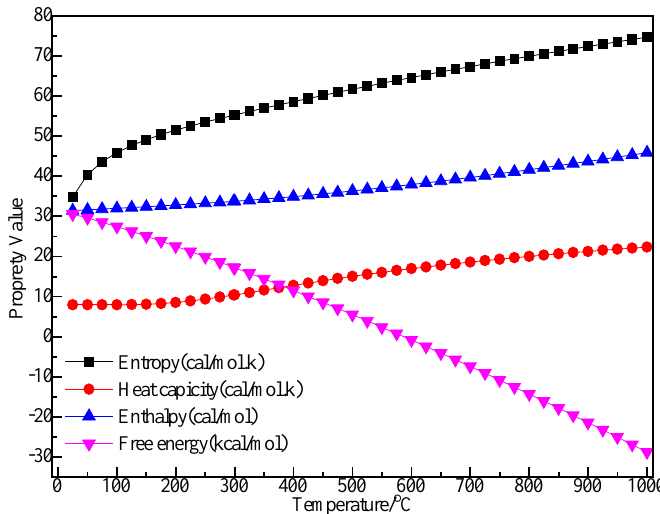
Figure 13. The relationship between the thermodynamic properties of C 2 H 4 and temperature.